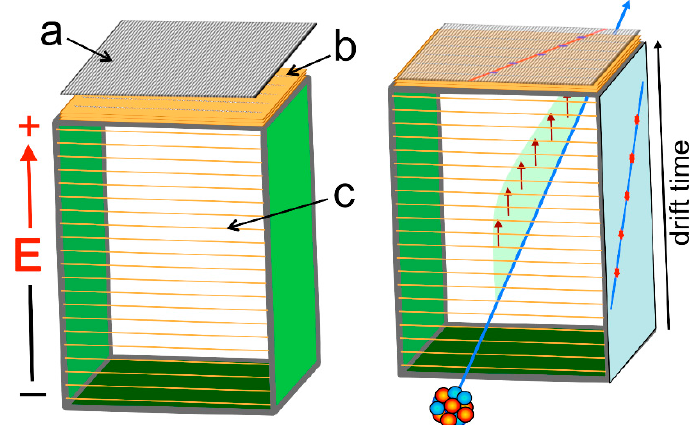
Figure 8. Operating principle of the gas Tracker. Left : (a) readout plane with finely spaced strip electrodes; (b) three MPGD planes with five rows of electron multiplying holes orthogonal to the strips; (c) drift field shaping wires. Right : each particle track produces five points on the XZ plane and five on the YZ plane, whose linear fits give rise to the desired quantities.